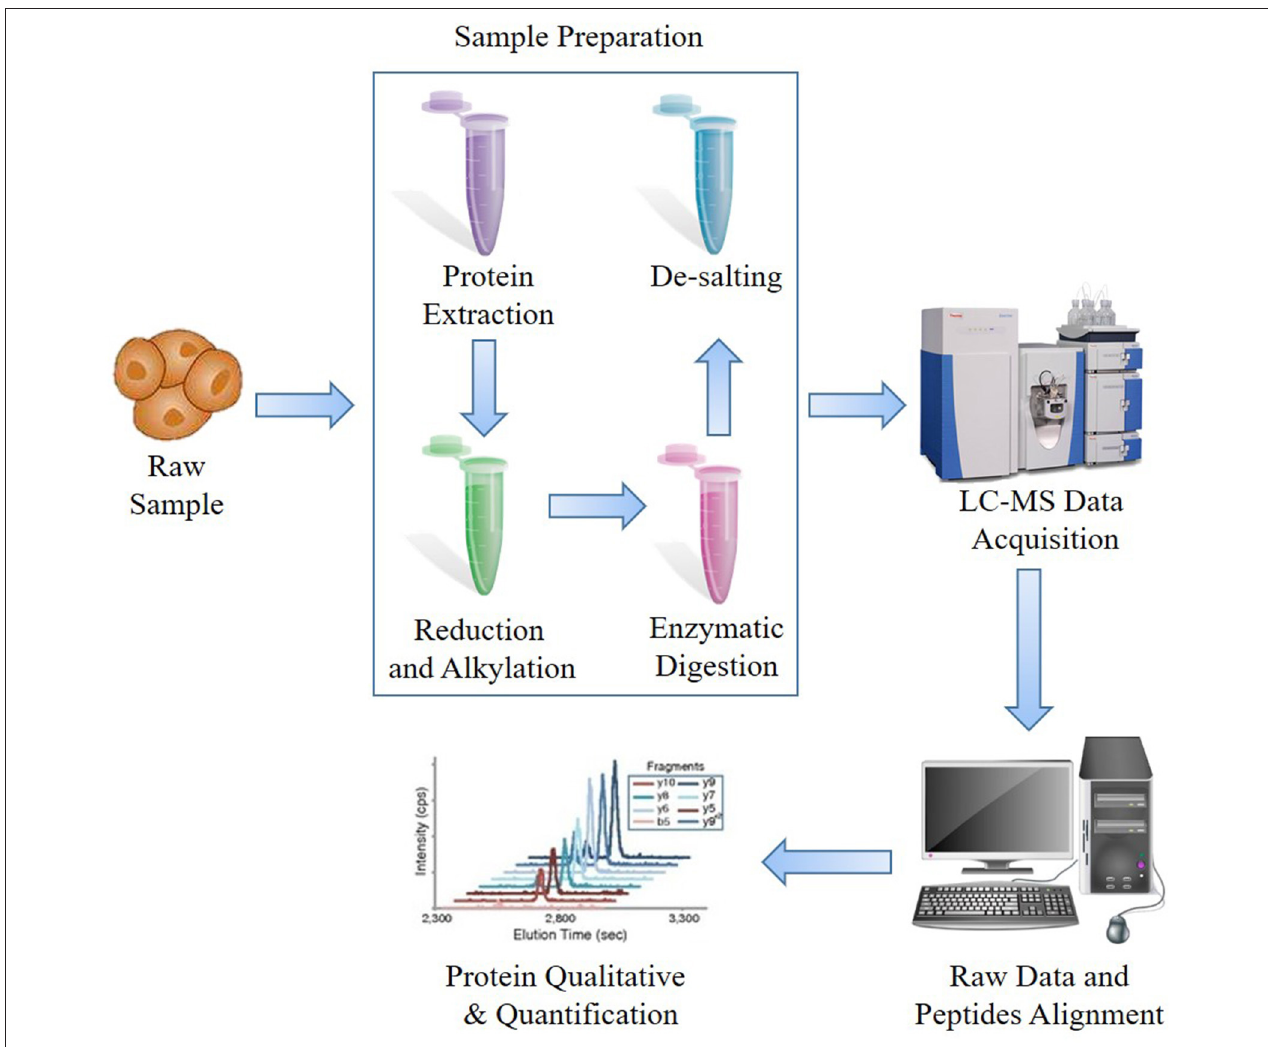
FIGURE 1 | General procedure of bottom-up proteomics (BUP) mass spectrometry (MS)-based